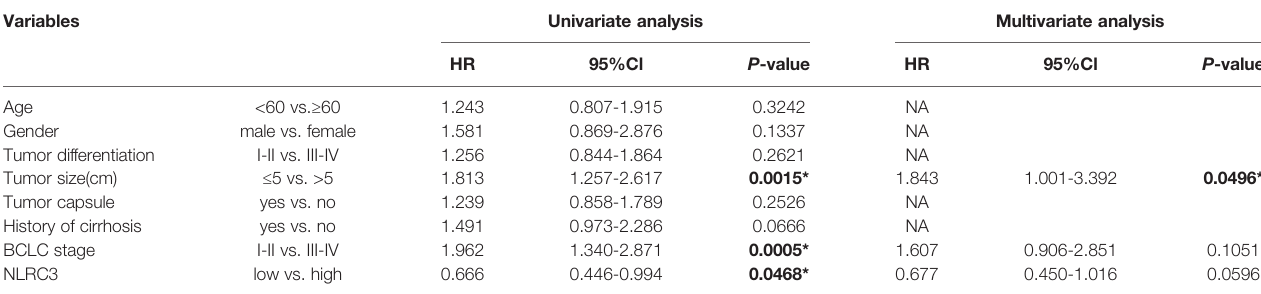
TABLE 3 | Univariate and multivariate analysis of clinicopathological and NLRC3 for disease-free survival (DFS) in patients with HCC (n = 211). Variables